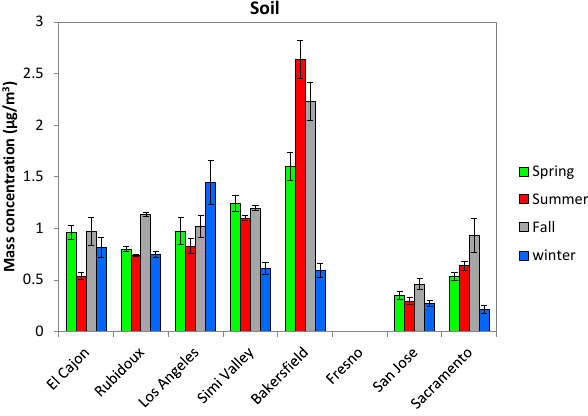
Figure 6. Seasonal average source contribution (µg/m 3 ) of soil to ambient PM 2.5 , by site. Error bars correspond to one standard error.